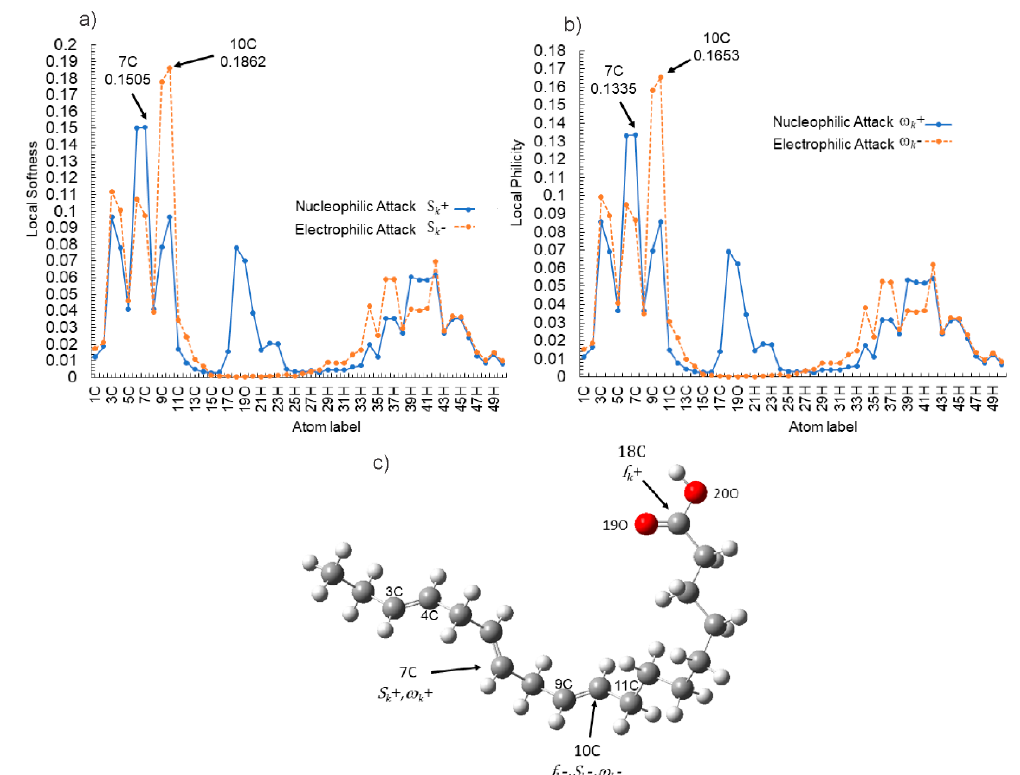
Figure 10. The lowest unoccupied molecular orbital (LUMO) of α -linoleic acid in the aqueous phase.